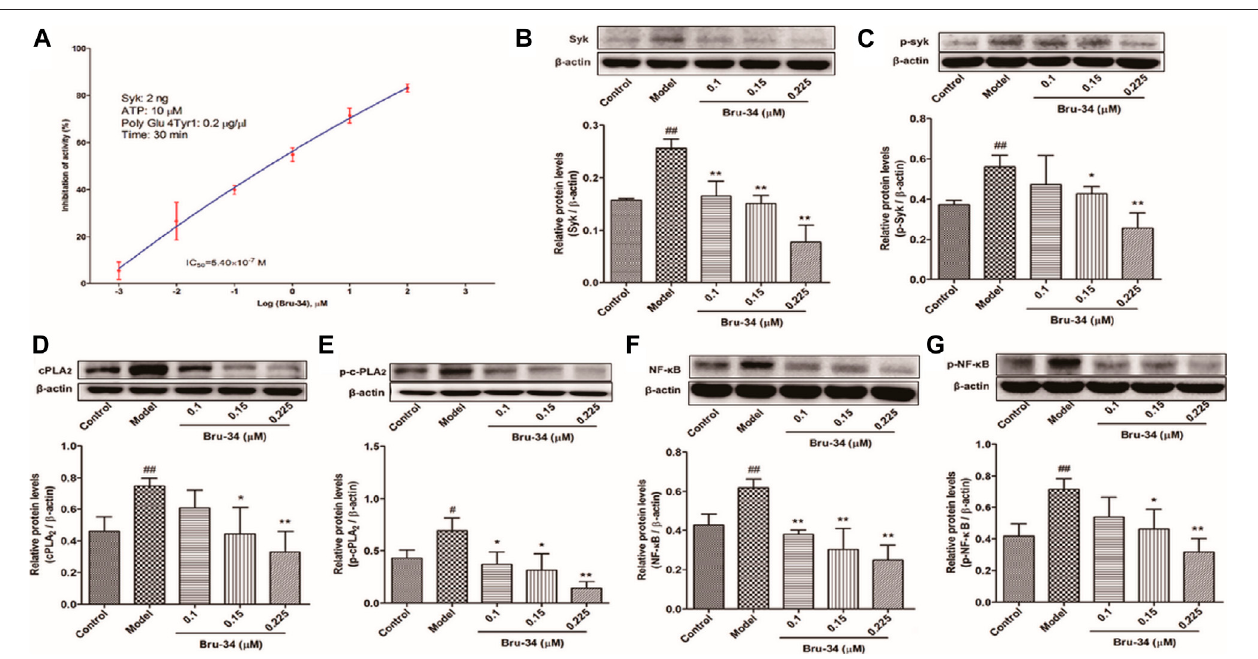
FIGURE6| Bru-34inhibitedSykkinaseactivities invitro andsuppressedtheproteinexpressioninantigeninducedRBL-2H3cells.Panel (A) :IC50determinationof Bru-34 on Syk kinase activity in vitro ; Panel (B) : the level of Syk determined by Western blotting; Panel (C) : the level of p -Syk determined by Western blotting; Panel (D) : the level of cPLA2 determined by Western blotting; Panel (E) : the level of p -cPLA2 determined by Western blotting; Panel (F) : the level of NF- κ B determined by Western blotting; Panel (G) : the level of p-NF- κ B determined by Western blotting; Data were given as mean ± S.D. n (cid:2) 3.